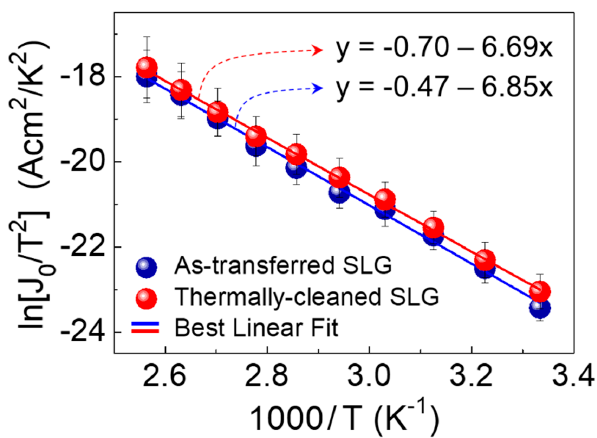
Figure 4. Richardson plots (i.e., ln( J 0 /T 2 ) vs. 1000/T) for the ZnO/AT-SLG and the ZnO/TC-SLG Schottky PDs. The symbols are the experimental data points, and the solid lines are the best-fitted curves to determine A* for the PDs. The error bars indicate the standard deviation from data obtained from multiple samples fabricated by identical procedures (i.e., five devices of ZnO/AT-SLG Schottky PDs and five devices of ZnO/TC-SLG Schottky PDs, see also Supplementary Materials).